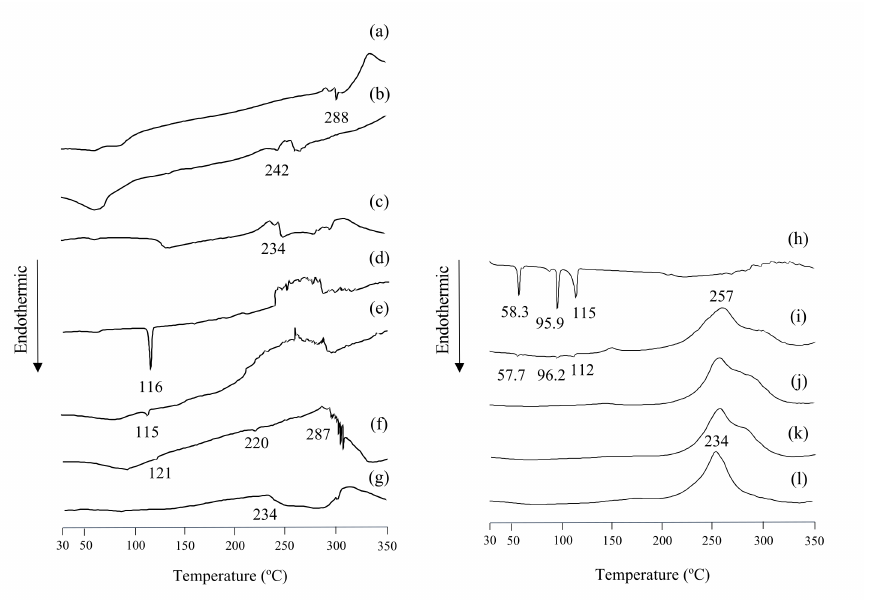
Figure 3. DSC curves of: ( a ) γ -CD; ( b ) CD-MOF-1; ( c ) EVP (CD-MOF-1); ( d ) ASCP intact; ( e ) PM (ASCP/CD-MOF-1 = 1/1); ( f ) EVP (ASCP/CD-MOF-1 = 1/1); ( g ) EVP (ASCP/CD-MOF-1 = 1/2); ( h ) ASCDP intact; ( i ) PM (ASDCP/CD-MOF-1 = 1/1); ( j ) EVP (ASCDP/CD-MOF-1 = 1/1); ( k ) EVP (ASCDP/CD-MOF-1 = 1/2); ( l ) EVP (ASCDP/CD-MOF-1 =